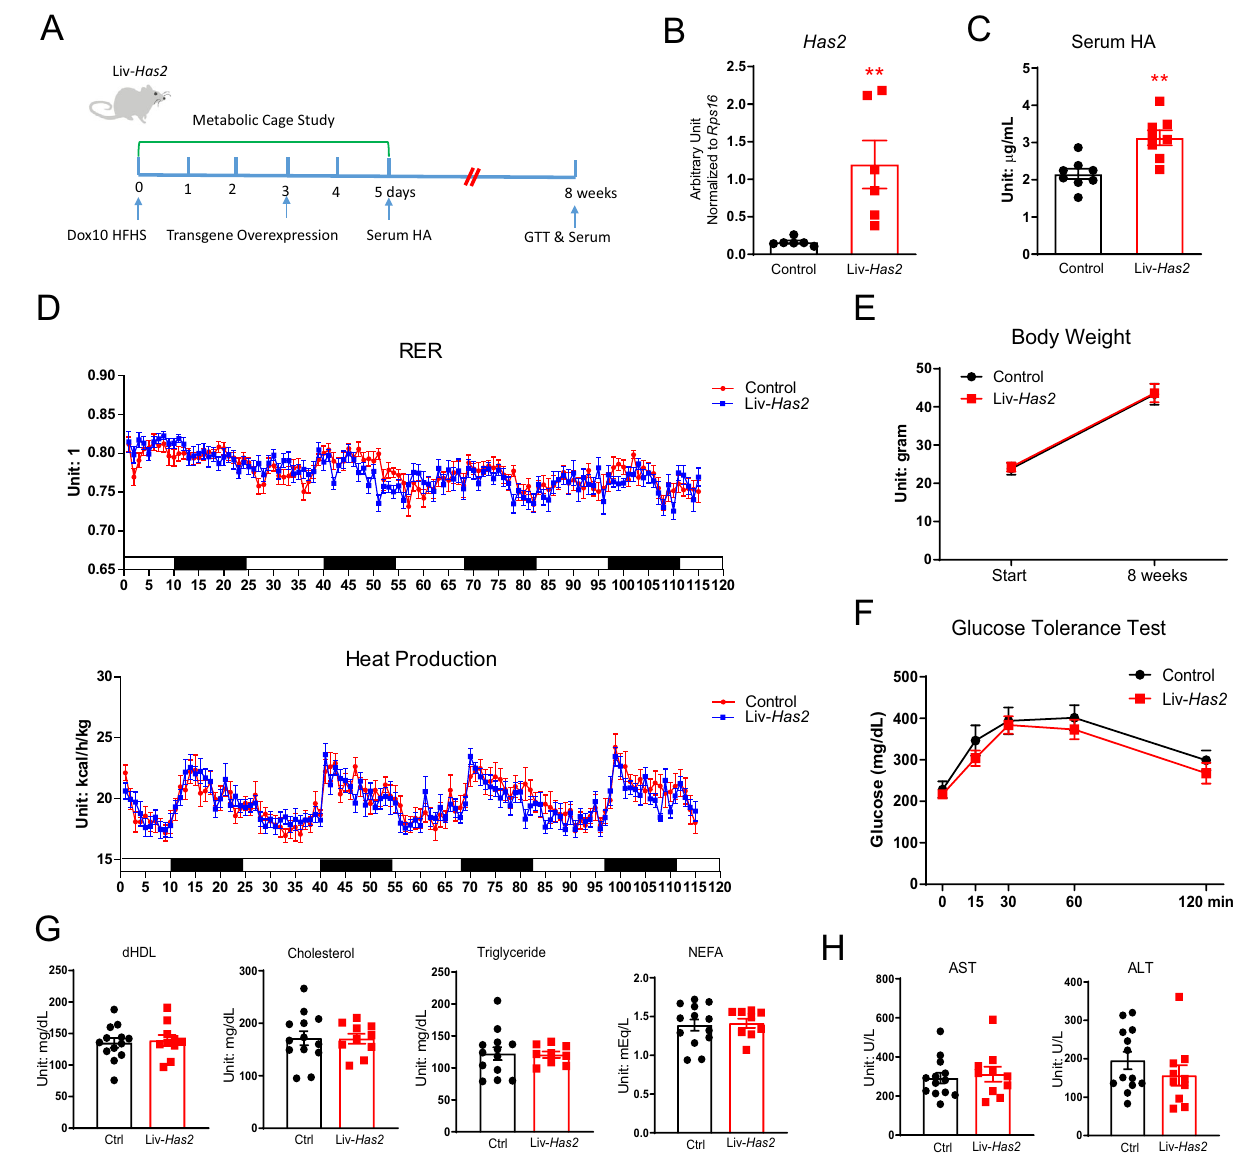
Fig. 6 Hepatic Has2 overexpression has no effect on glucose tolerance. A Schematic representation of Liv- Has2 mouse treatment for panels B – H . Multiple cohorts of mice were used. B Has2 gene expression in Liv- Has2 livers on Dox10 HFHS diet for 3 days ( n = 6 mice). Two-tailed t -test, p = 0.0013. C Serum HA for Liv- Has2 mice on Dox10 HFHS diet for 5 days ( n = 8 mice). Two-tailed t -test, p = 0.009. D RER and calculated heat production in Liv- Has2 mice during 5-day of Dox10 HFHS diet feeding starting on the day 0 of metabolic cage study ( n = 12 mice). E Body weight of Liv- Has2 mice before and after Dox10 HFHS diet for 8 weeks ( n = 6 mice for control, n = 7 mice for Liv- Has2 ). F Glucose tolerance test of Liv- Has2 mice after 8 weeks of Dox10 HFHS treatment ( n = 6 mice for control, n = 7 mice for Liv- Has2 ). G Serum lipids levels of Liv- Has2 mice after 8 weeks of Dox10 HFHS treatment ( n = 13 mice for control, n = 10 mice for Liv- Has2 ). H Serum AST and ALT levels of Liv- Has2 mice after 8 weeks of Dox10 HFHS treatment. ( n = 13 mice for control, n = 10 mice for Liv- Has2 ). All data are presented as mean ± s.e.m. **indicates p ≤ 0.01. Two-tailed t -test ( G ) ( H ); two-way ANOVA ( D ) ( E ) ( F